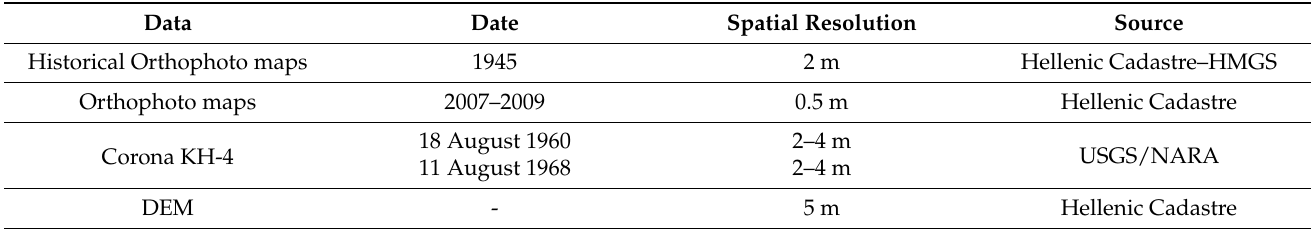
Table 1. Specifications of aerial and satellite imagery used in this